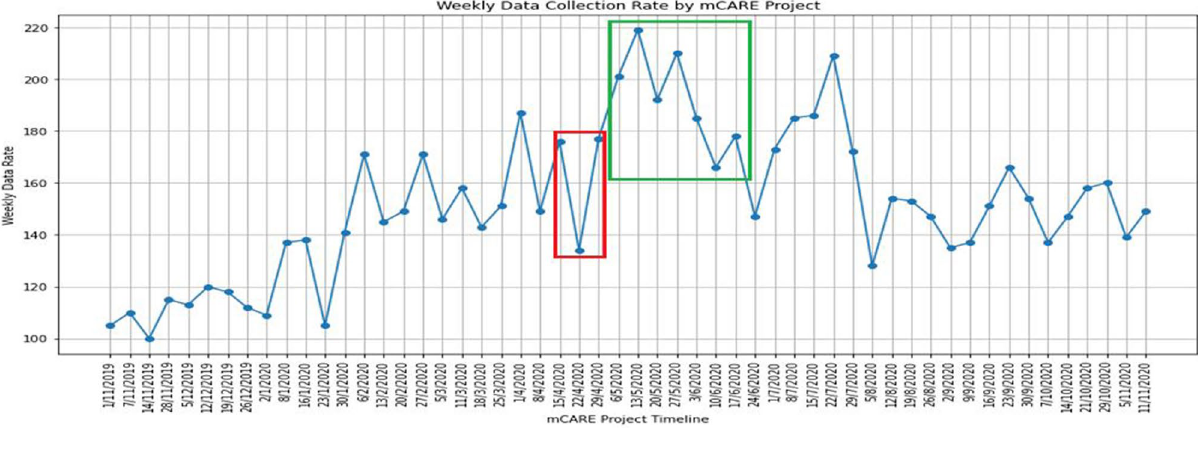
Figure 1. mCARE data collection rate